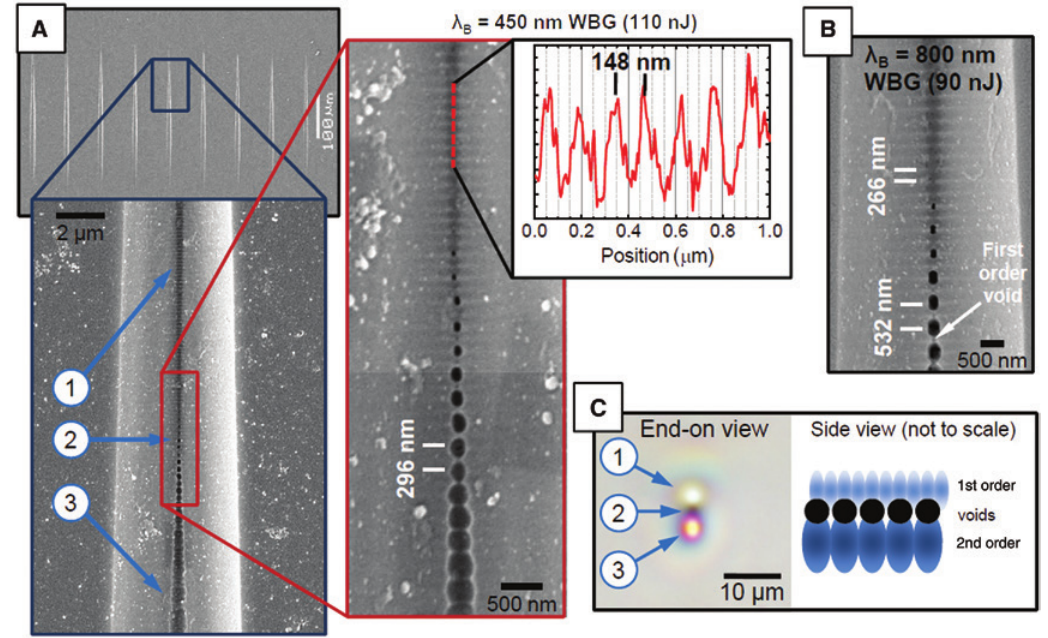
Figure 25: (A) Scanning electron microscopy (SEM) images of WBGs with periods of 148 nm. The top left image shows an overview of a WBG set looking straight onto an angled polished face of the sample. In all images, the writing laser was incident from the top. A profile along the vertical dashed red line is shown in the top right corner. (B) Each WBG, irrespective of its Bragg wavelength, showed a first-order struc- ture above the focal spot and second-order structure below the focal spot with microvoids in between ( λ The white arrow marks a tiny first-order damage. (C) Three regions are apparent in the end-on view, which can be correlated with the SEM images. Above the focal spot (1) is a first-order grating structure, at the focal spot (2) are second-order periodic voids, and below (3) are second-order grating